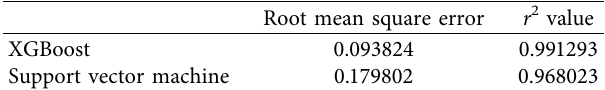
Figure 19: Comparison between the RMSE and R-squared values of XGBoost and SVR for Aman yield prediction.